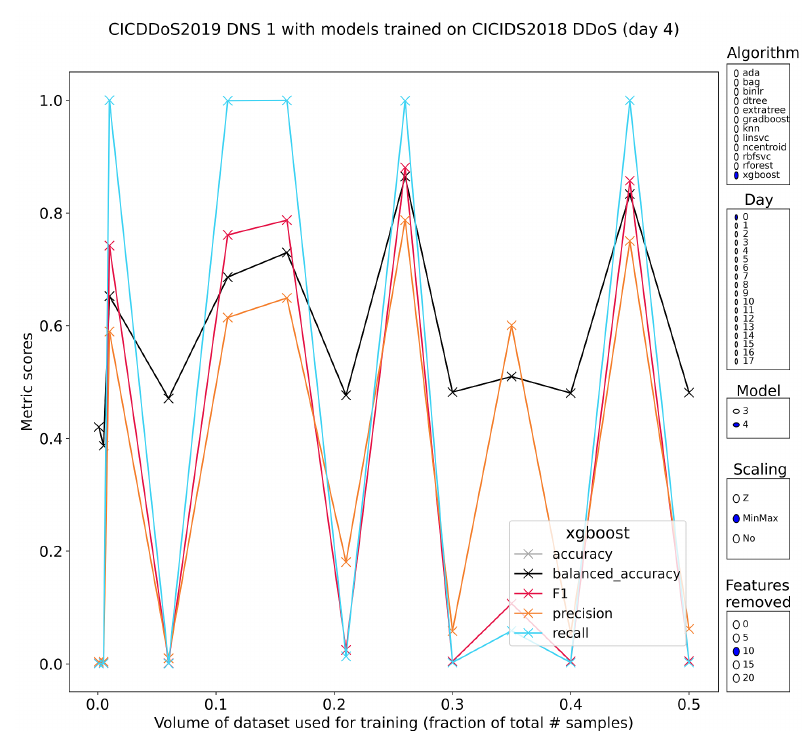
Figure 10. Generalized performance of DDoS models pretrained on CSE-CIC-IDS2018 DDoS has the potential to be high, but the volatility precludes